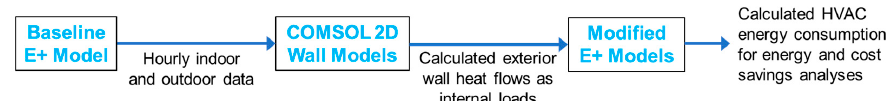
Figure 5. Flowchart illustrating the modeling and analysis process for the annual simulations.